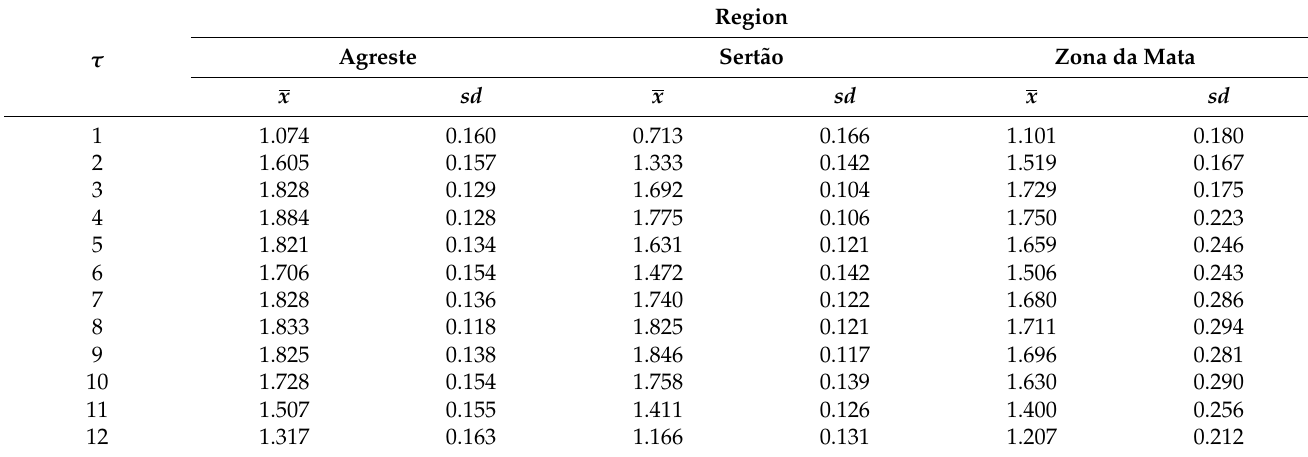
Table 1. Average MMSE values (together with standard deviation) for rainfall temporal series.